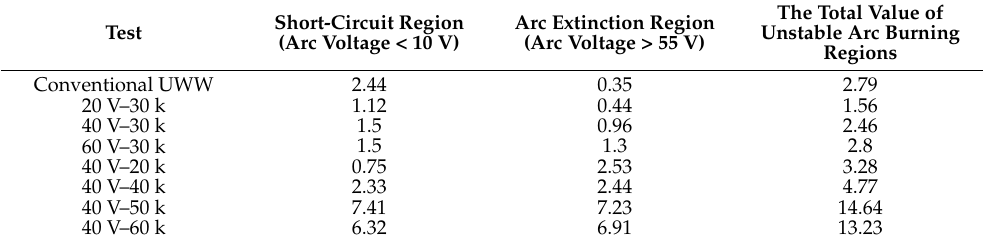
Table 3. The proportions of low (<10 V) or high (<55 V) arc voltage at different welding parameters (%). The Total Value of Arc Extinction Region Test Short-Circuit Region Unstable Arc Burning (Arc Voltage > 55 V) (Arc Voltage < 10 V) Regions Conventional